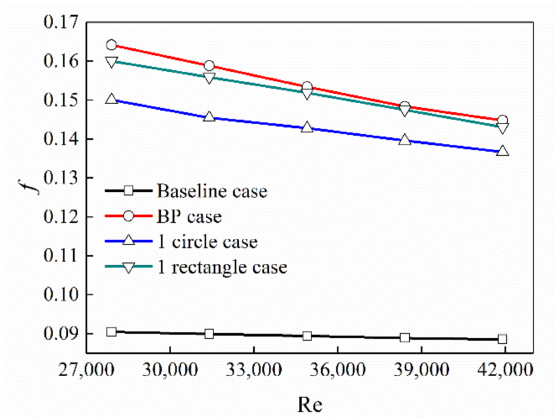
Figure 9. The relationship between the shell side drag coefficient and Re.